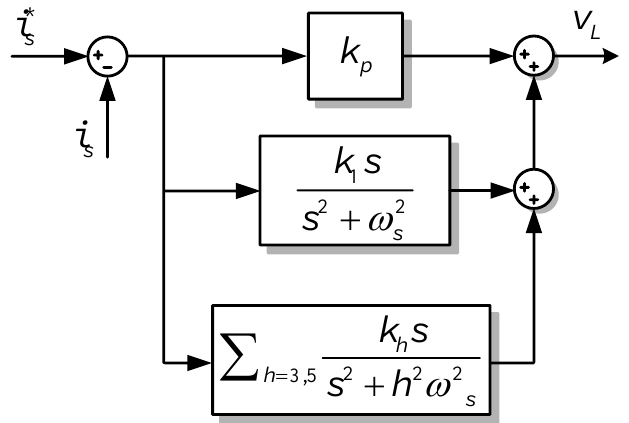
Figure 5. Stationary current control loop implemented with PMR